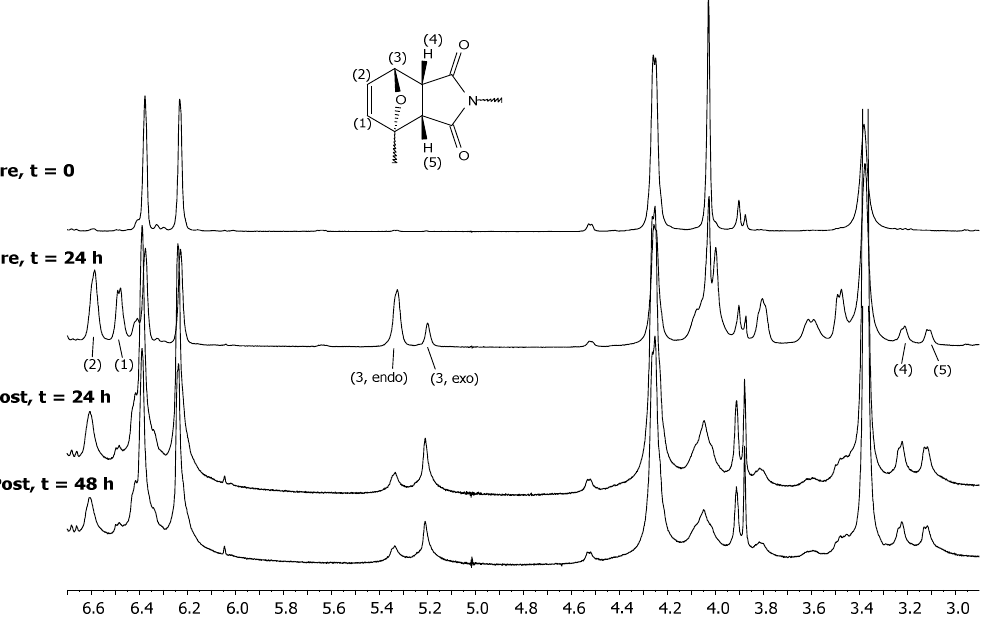
Figure 4. 1 H-NMR spectra of PE-fur/Bism recorded at various moments before and after